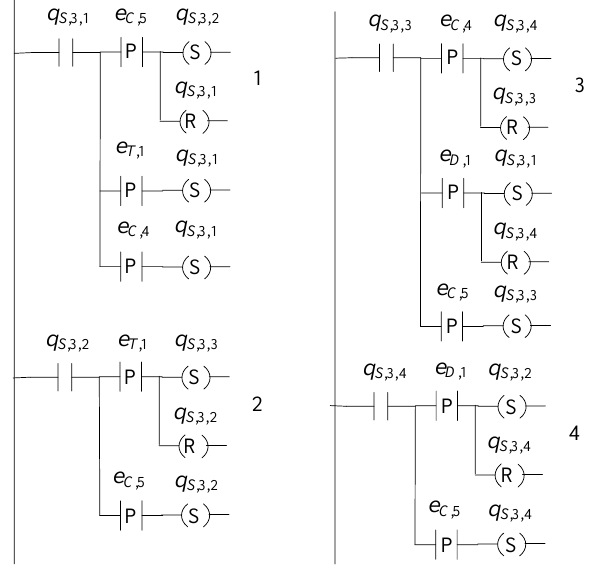
Figure 14. State diagram of